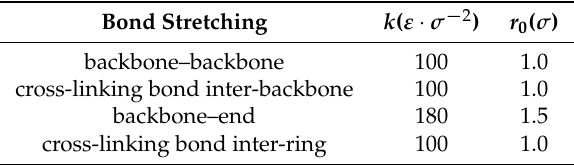
Table 2. Parameters for the bond stretching